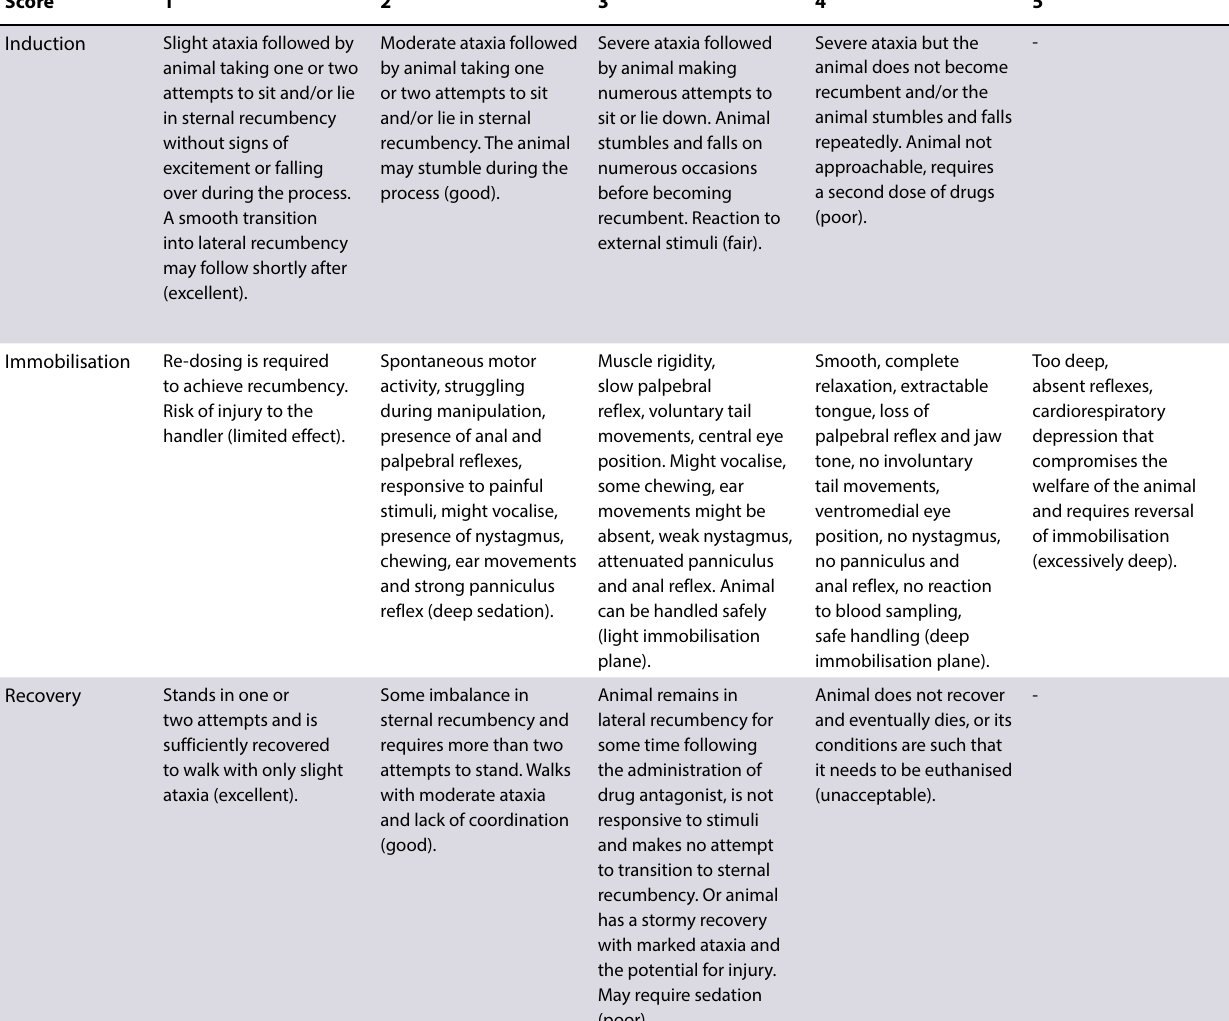
Table I: Description of the scoring system used to categorise the quality of induction, immobilisation, and recovery (Gaudio et al. 2019 and Pfitzer et al. 2019) Score Induction